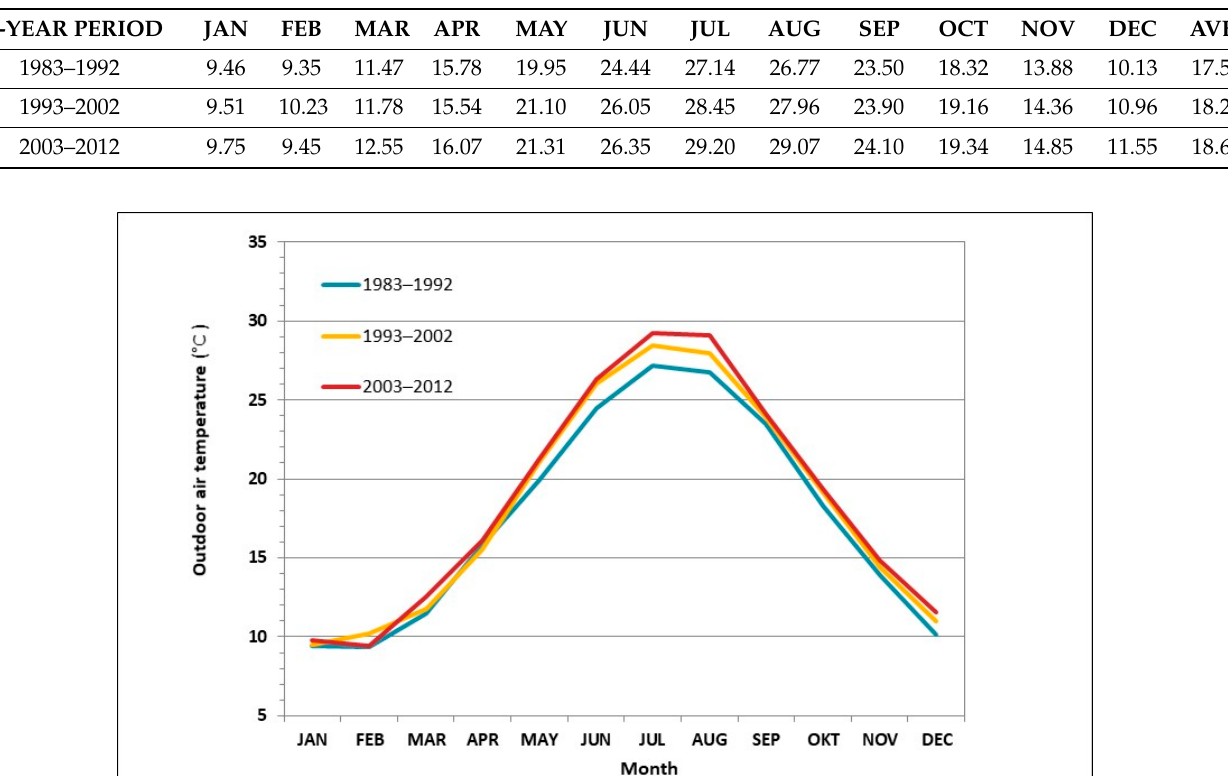
Figure 1. Average values of mean monthly air temperatures in Athens (NOA) for the three decades 1983–1992, 1993–2002 and